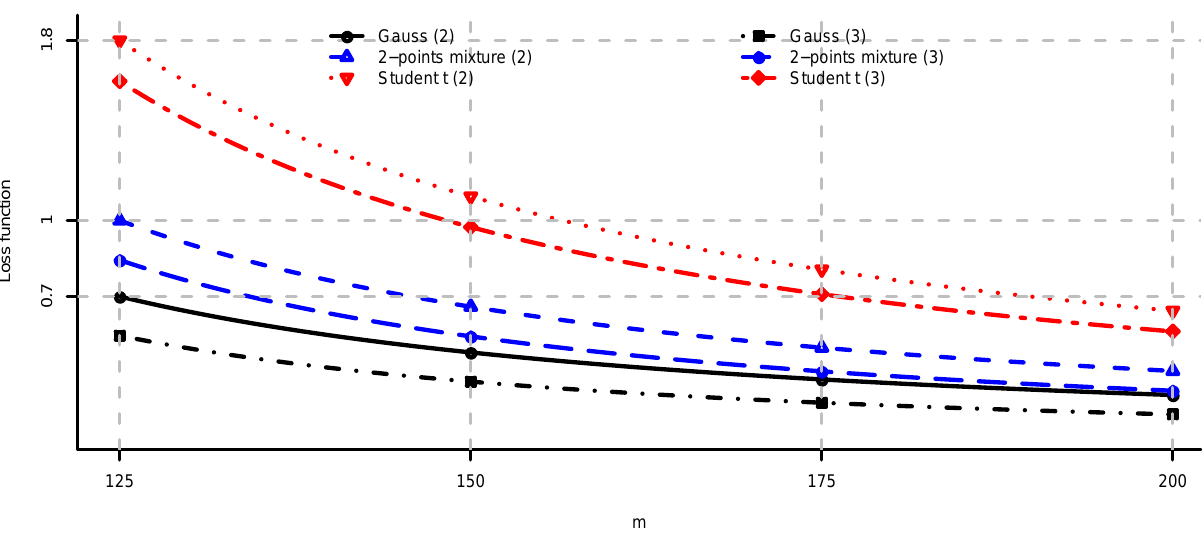
Figure 3. Loss functions (2) and (3) for n = 50 and different values of m .